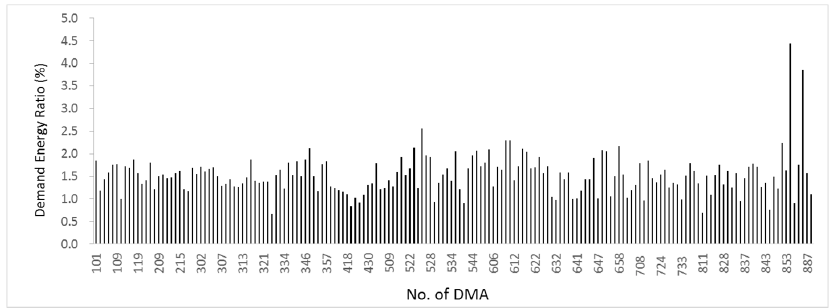
Figure 9. Data on No. of Leaks in Incheon’s DMAs. Figure 10. Data on Mean Pipe Dimeter in Incheon’s DMAs. The average value of the pipe length per demand junction (km/no. of junctions) is 0.0336; the maximum value is 0.75 (DMA No. 418) at the beginning of the No. 400 DMA located in industrial district, and; the number of demand junctions is lower than in residential district. Compared to other DMAs, pipe length of industrial district is longer than other districts for water delivery in each DMA.